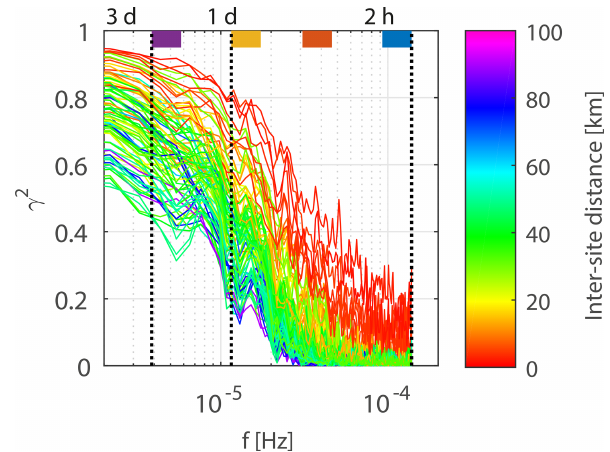
Figure 10. Squared coherence functions for all possible site pairs out of the 14 turbine power output time series placed at favorable wind farm locations marked in Fig. 2 (total of 91 pairs). The col- ors of the coherence functions represent the distances in kilometers between site pairs; see color bar. The four colors marked at the top of the figure are added to mark the frequency ranges considered in Fig. 11.